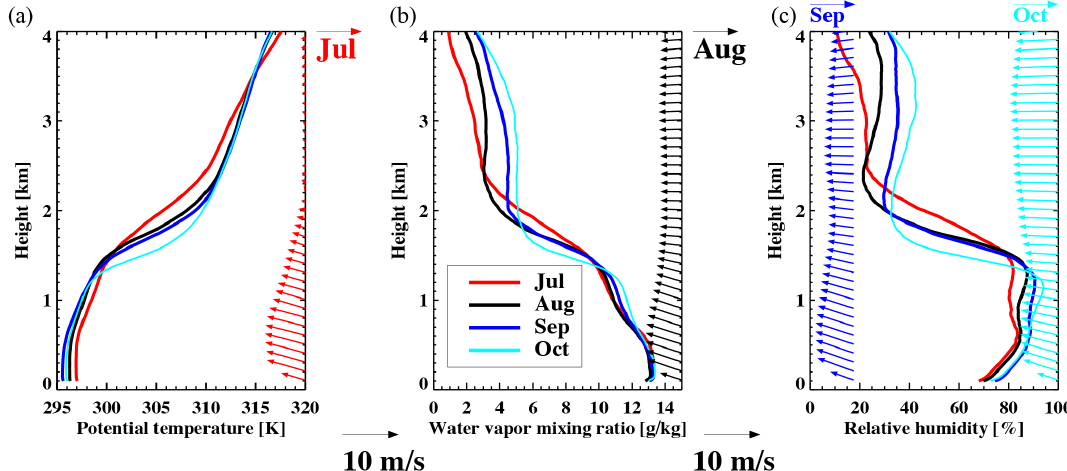
Figure 4. Monthly mean radiosonde profiles (0–4km above sea level) of (a) potential temperature, (b) water vapor mixing ratio, (c) relative humidity, and winds (colored vectors), by month, for 2016 and 2017 combined.